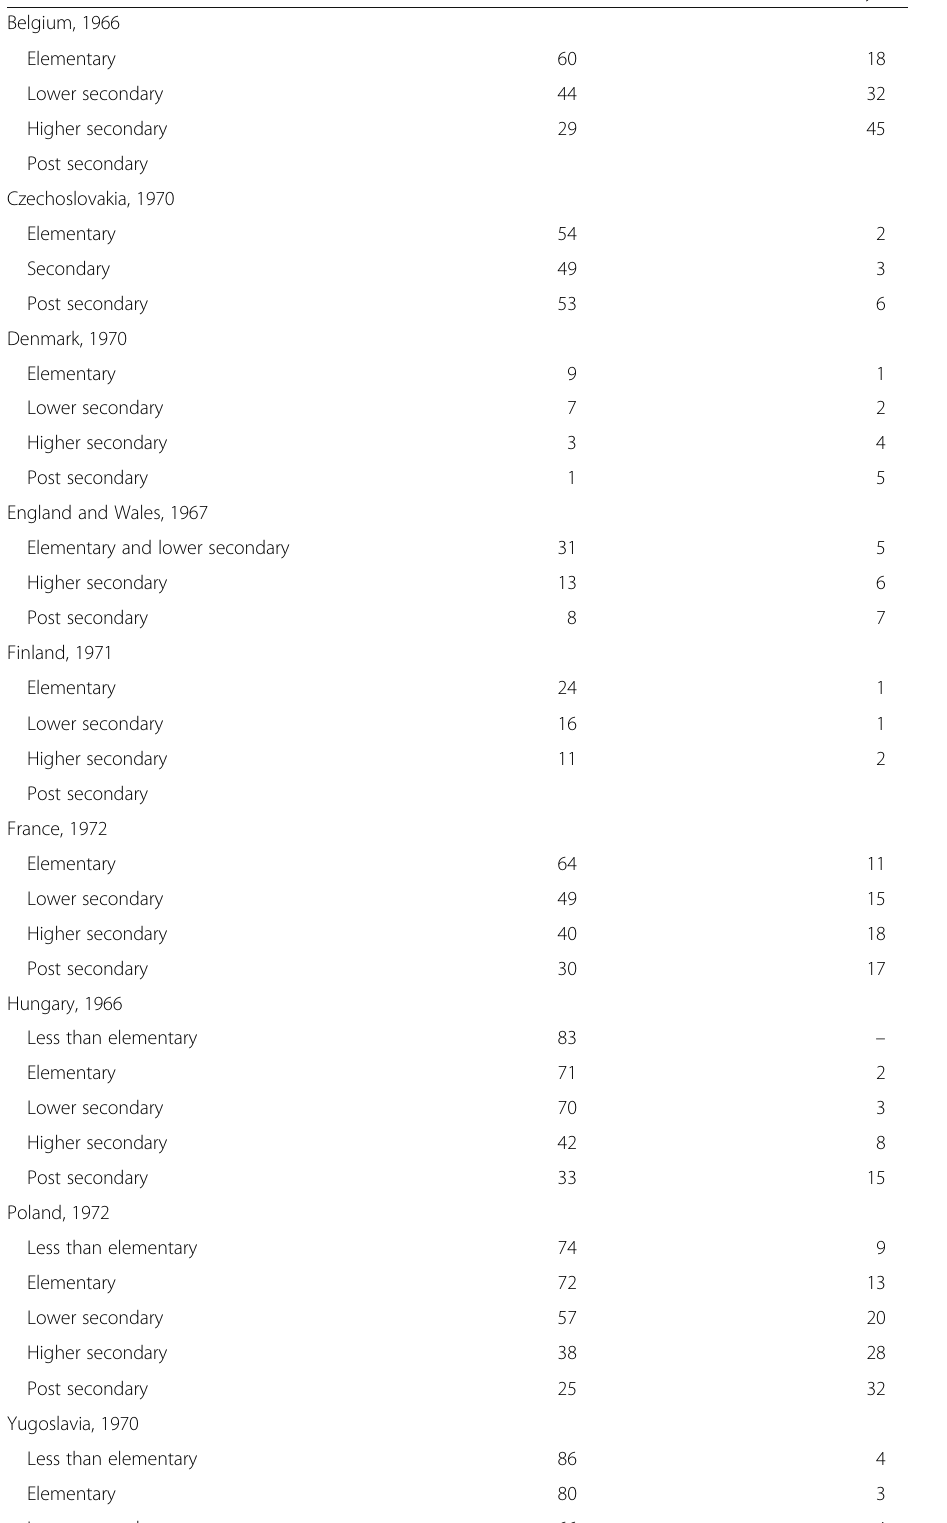
Table 10 Percent of users, currently using withdrawal or rhythm according to wife ’ s education Wife ’ s